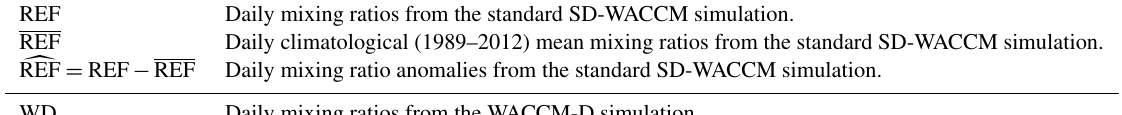
Figure 1. Maximum proton flux of solar proton events used in the analysis as a function of the day of the year of the SPE onset. Events with maximum flux over threshold value (100pfu) are shown as red bars and smaller events as blue bars. Table 1. Definitions used in the text for the SD-WACCM and WACCM-D simulations. REF Daily mixing ratios from the standard SD-WACCM